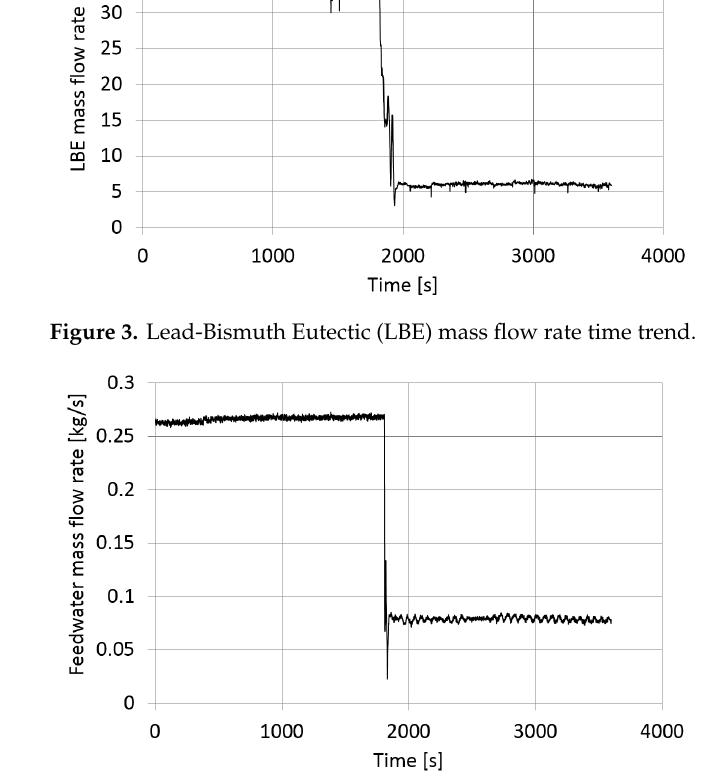
Figure 4. Feedwater mass flow rate time trend.